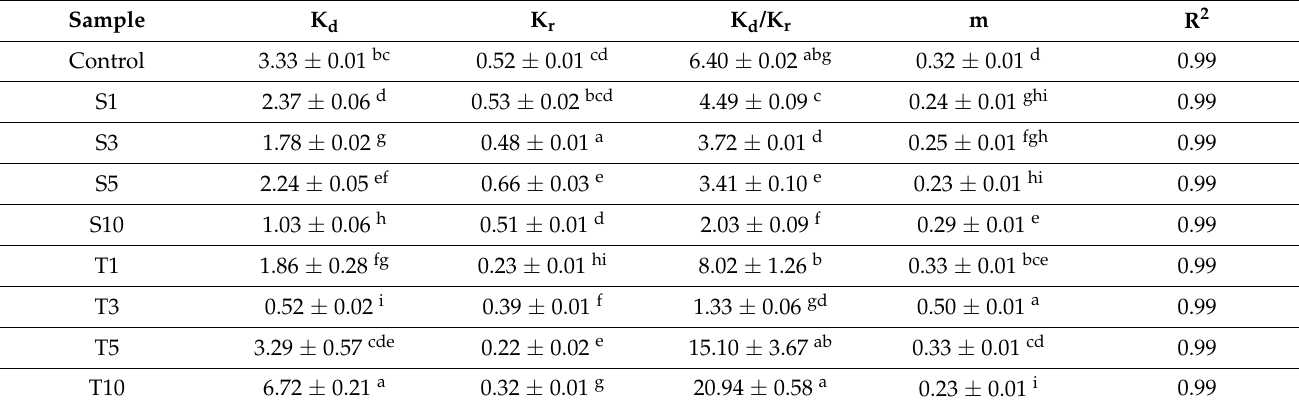
Table 4. Parameters of Peppas Sahlin (PS) model of drug